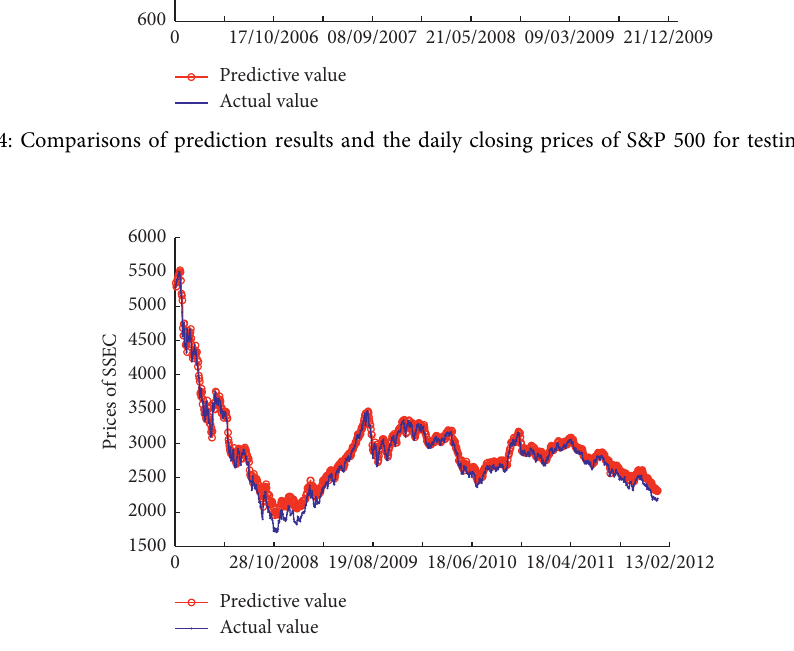
Figure 5: Comparisons of prediction results and the daily closing prices of SSEC for testing datasets. Table 3: Comparisons of prediction performances among different models for θ � 0.